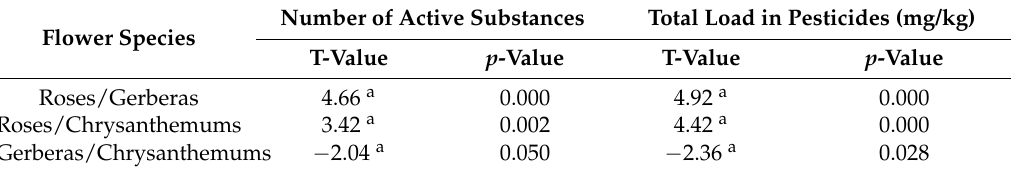
Table 3. Statistical analysis (Student’s t -test, using Minitab ® 16 software) of the contamination levels (number of a.s. found and the total load average in pesticides per sample) and comparison between the three species.